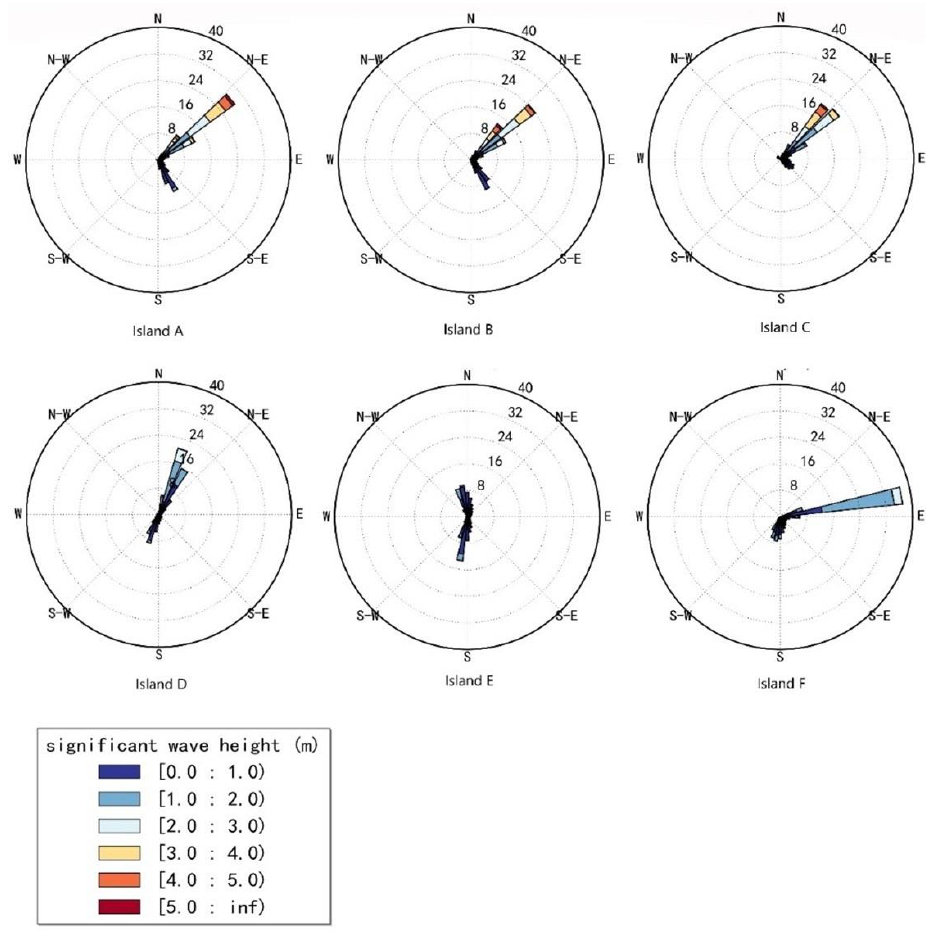
Figure 20. Rose plot of H s at reference sites in the Xisha Islands.